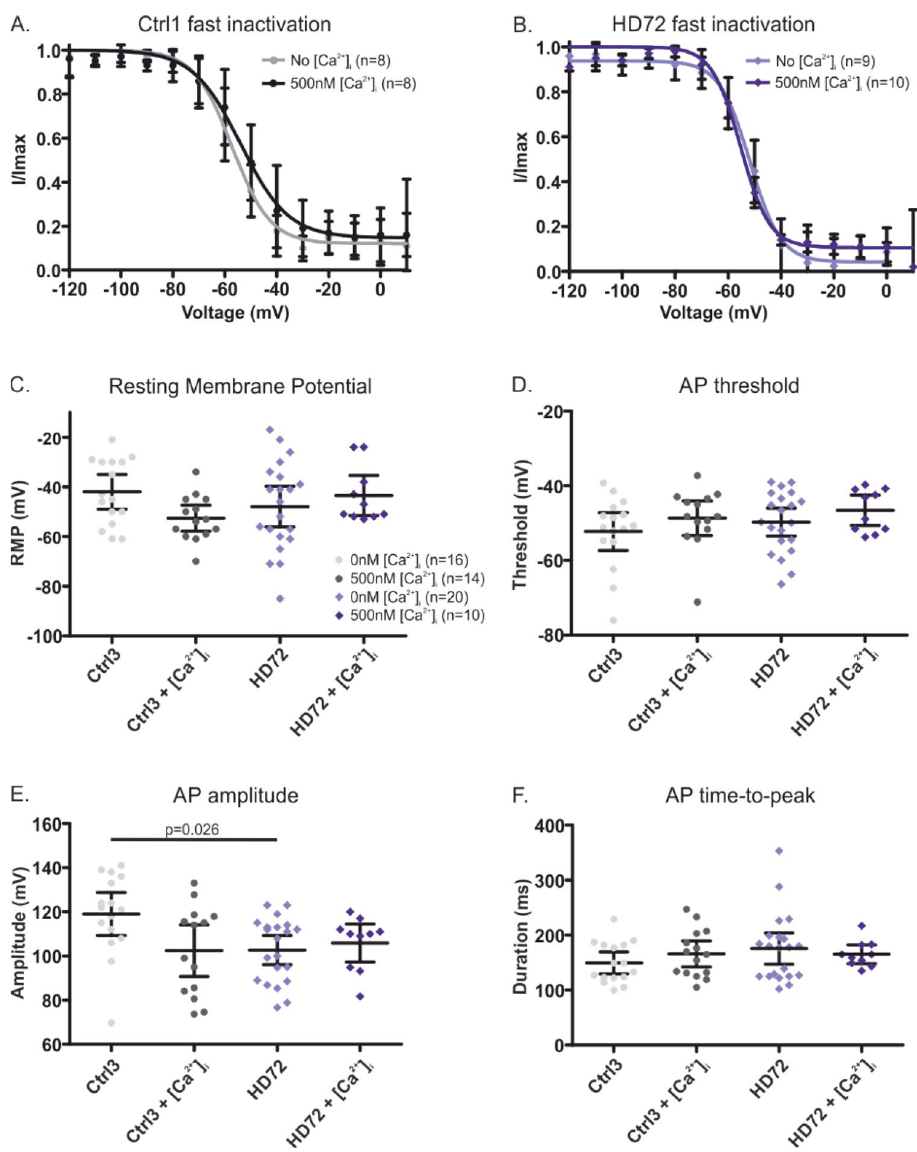
Figure 8. Changing internal Ca 2+ does not affect steady-state fast inactivation or AP properties of hiPS cell- derived neurons from the Stanslowsky protocol. ( A , B ) Steady-state fast inactivation with and without 500 nM [Ca 2+ ] i in Ctrl1 ( A ) or in HD72 hiPS cell-induced neurons of the Stanslowsky protocol ( B ) (n = 8–10 neurons). ( C , F ) Effect of 500 nM [Ca 2+ ] i on AP characteristics in hiPS cell-derived neurons of Ctrl3 and HD72 of the Stanslowsky protocol (n = 9–22 neurons). ( C ) Resting Membrane Potential, ( D ) AP threshold, ( E ) AP amplitude, ( F ) AP time-to-peak. All data shown as mean ± 95% CI. See Supplementary Table S12 for